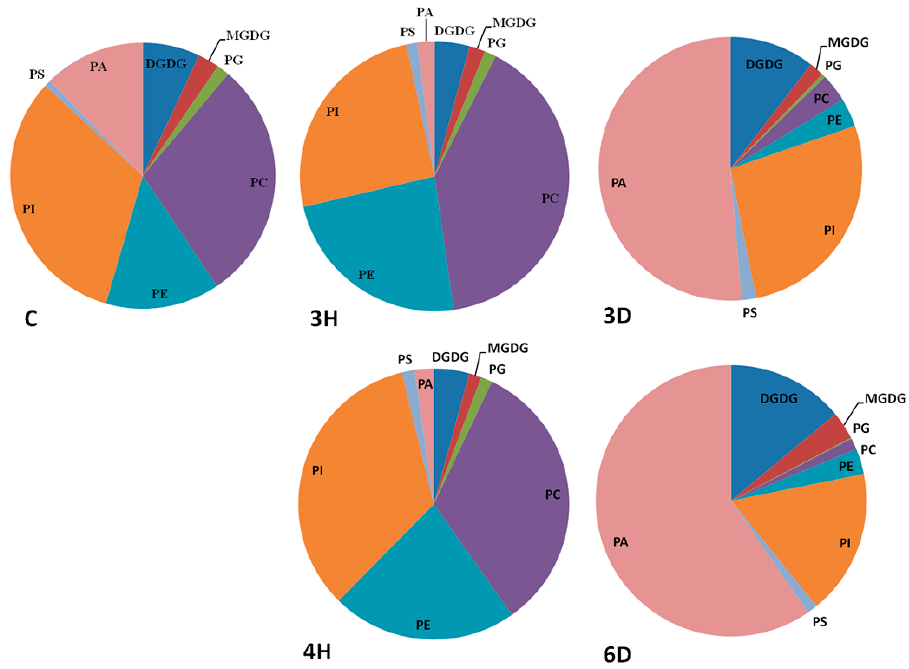
Figure 5. Contributions of the membrane lipids in each head-group class to the total membrane lipid contents of the A. thaliana seeds during the hydration–dehydration cycles. The treatment was the same as that described in Figure 3.